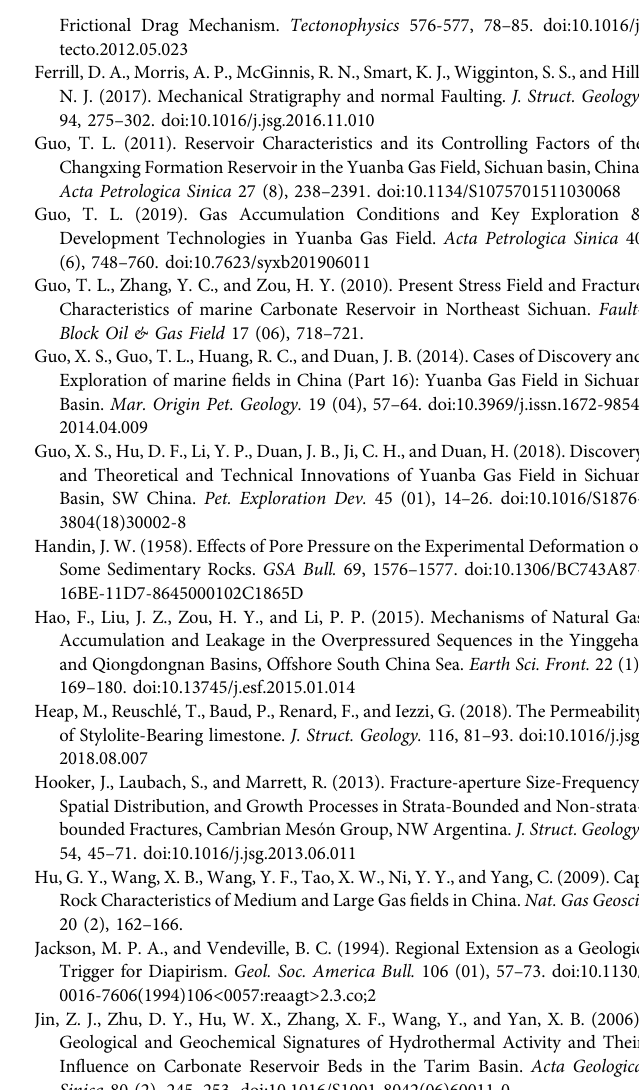
Supplementary Figure S2 | Strengths of the limestone in the Yuanba Gas Field under various con fi ning pressures. The solid and dashed lines in b are the strengths ofSolnhofenlimestone(Rutter,1986).Thesmallsquaresarethemeasurementdata. The average density of the overburden rocks is 2.63 g/cm 3 , and Poisson ’ ratio is 0.35. Supplementary Figure S3 | Reservoir formation mechanism of the Yuanba Gas Field. Supplementary Figure S4 | Gas migration and charge via intersections of delaminated fractures. (A) Fractures in the upper layer; (B) fractures in the lower layer; (C) gas migrating from the lower layer to the upper layer via the intersections (small